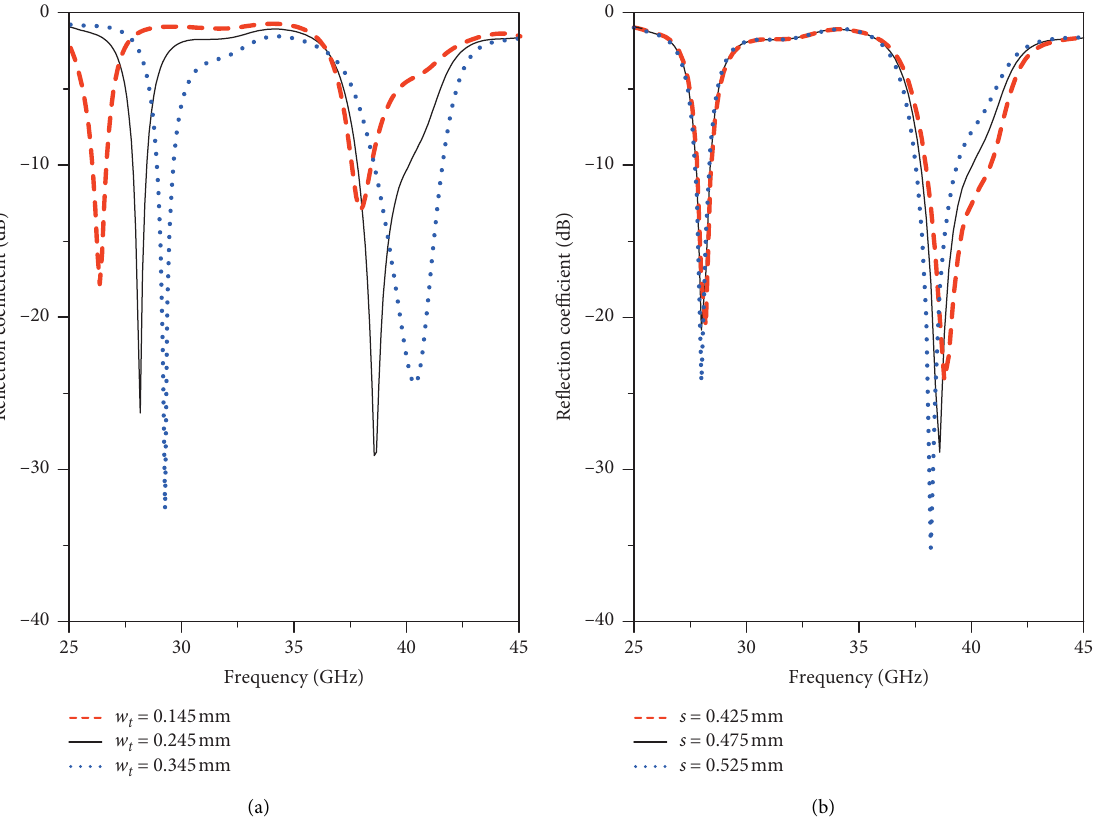
Figure 4: Parametric analysis of the proposed unit element. Efect of the variation of (a) w